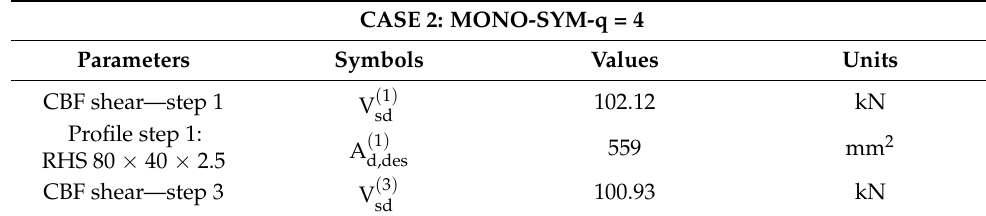
Table 5. Results of case study 2.